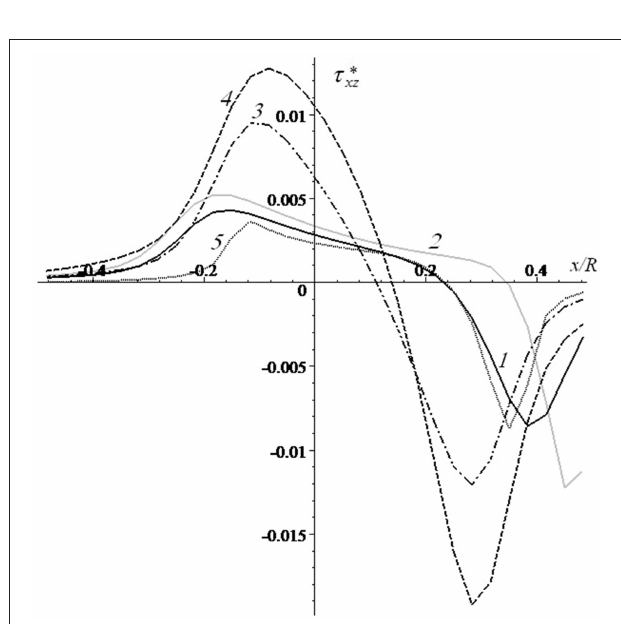
FIGURE 9 | Distribution of stresses τ * xz at the layer-substrate interface [ V ∗ = 0.333 (curves 1,2,4,5), V ∗ = 1.666 (curve 3); c = 5 (curves 1, 3-5), c = 20 (curve 2); h ∗ = 0.1 (curves 1-4), h ∗ = 0.033 (curve 5); ν = 0.3 (curves 1-3, V ∗ = 0.333 5), ν = 0.45 (curve 4); (curves 1, 3-5), Q ′ = 0.035 (curve 2)].